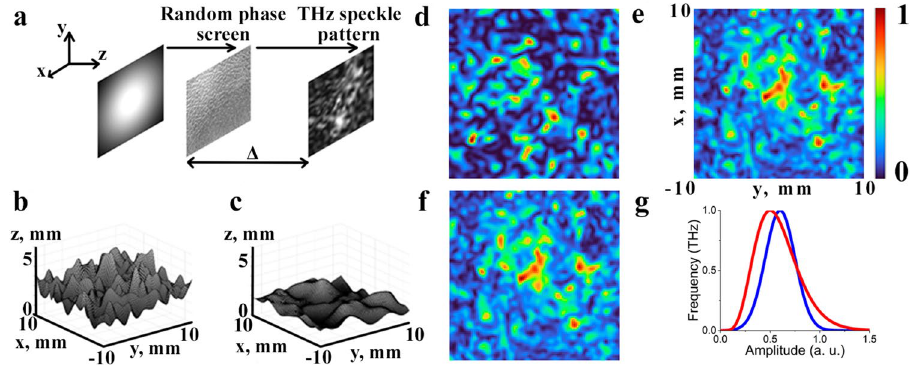
Figure 1. ( a ) Scheme of acquisition of speckle patterns for monochromatic THz radiation: beam with Gaussian intensity distribution transmits through the random phase screen and propagates over the distance (cid:31) = 5 cm. ( b , c ) Two samples of Gaussian random rough surface. Surface has large value of h RMS and low value of Cl ( b ), low value of h RMS and large value of Cl ( c ). Speckle patterns produced by ( d ) monochromatic THz radiation with frequency ν = 0.7 THz, produced by pulsed THz radiation with symmetric spectrum ( e ) and spectrum with shifted central frequency ( f ). Spectrum ( g ) with a blue curve has a symmetric Gaussian shape, spectrum with red curve has gaussian shape with shifted central frequency. As a material of plate with random rough surface on its back side with refraction index n = 1.55 for THz spectral range was used, parameters of the surface are h RMS = 0.3 mm and Cl = 0.9 mm. The distance between random phase screen and speckle pattern observation plane is (cid:31) = 5